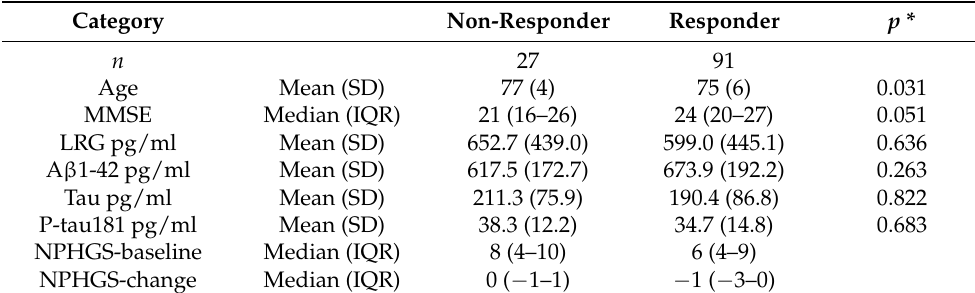
Table 5. CSF biomarker levels according to the shunt